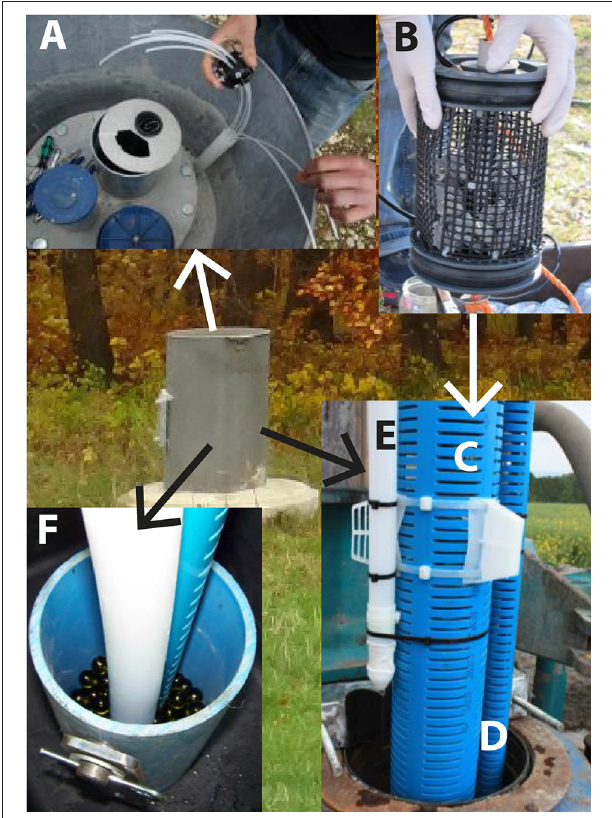
FIGURE 6 | Unique construction of ground water wells in the Hainich transect. Center: aboveground well structure. (A) View from the top with open well. (B) passive samplers that are filled with rock material suspended in groundwater to study attached organisms (C) Main screenpipe (6 inch 6 ′′ ) for groundwater sampling and installation of passive samplers (D) Secondary screenpipe (2 ′′ diameter) for permanent installation of p-T dataloggers and in-line optical sensors. (E) multi-channel tube with up to seven access ports for gas phase sampling. (F) backfilling of well with glass beads as a chemically inert